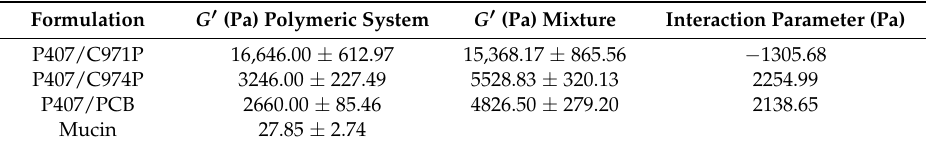
Table 5. Values of the elastic modulus ( G (cid:48) ) for polymeric blends containing poloxamer 407 (P407) and value represents the mean ( ± standard deviation) of at least six